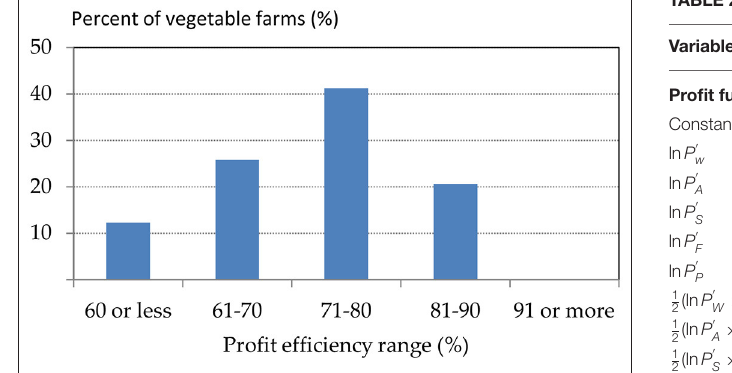
TABLE 2 | Maximum likelihood estimates of stochastic translog profit